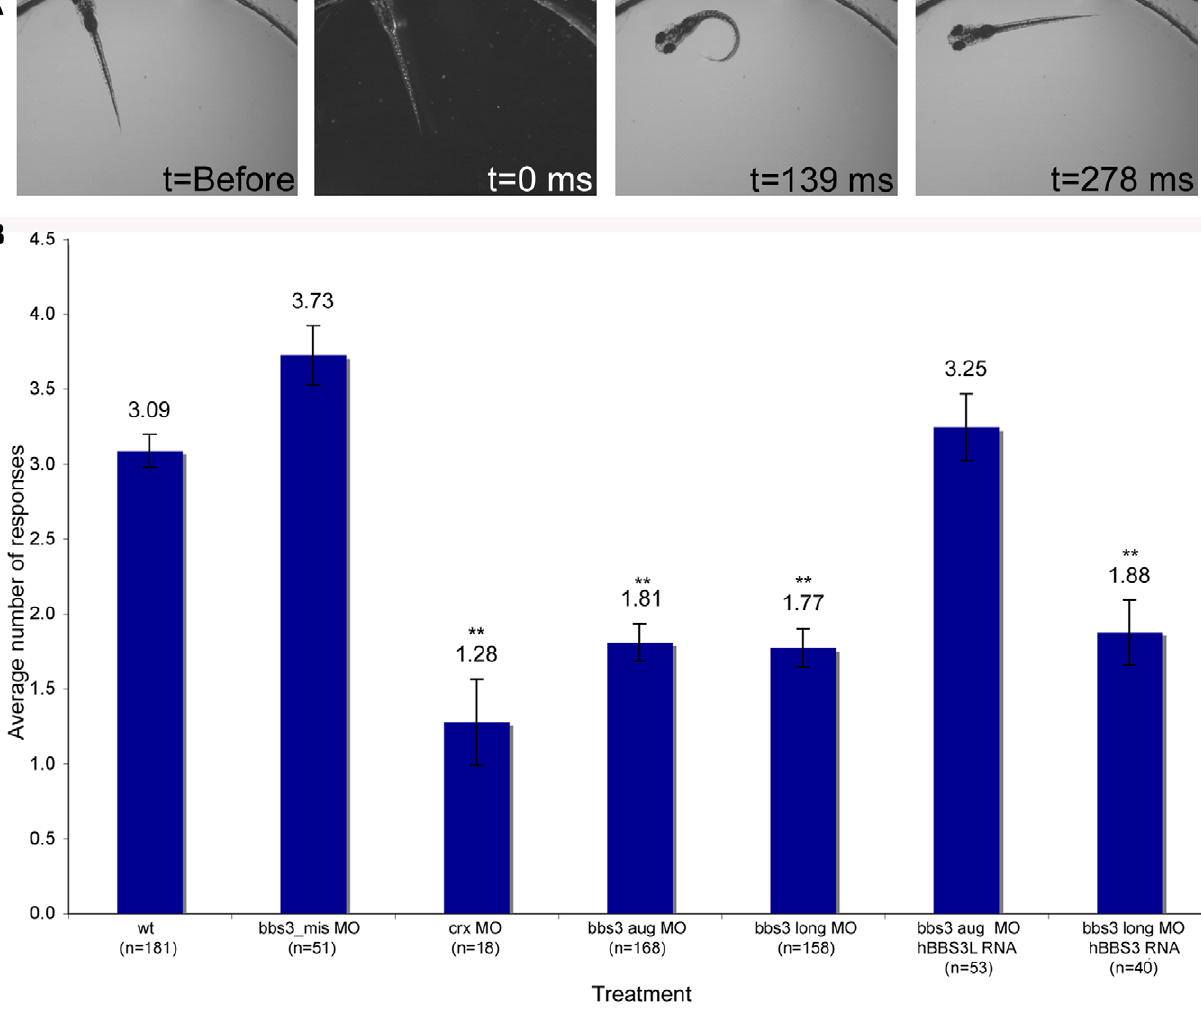
Figure 3. Vision startle response in zebrafish. (A) Vision function was assayed in 5-day old embryos by testing embryos sensitivity to short blocks in light at 30 second intervals for 5 trials (adapted from Easter and Nicola 1996). Selected images from a time-lapse collection before and immediately after a one second block in light. The typical response, a distinct C-bend, is scored as a positive response as shown in time point 139 ms. ms, milliseconds. (B) Quantification of the vision startle response for each treatment. Cone-rod homeobox ( crx ) gene knockdown was used as a control for vision impairment. bbs3 morphants lacking either both transcripts or only the long transcript showed a statistically significant reduction in the number of responses, indicating visual impairment. Rescue experiments using wild-type human BBS3L or BBS3 RNA co-injected with the bbs3 morpholinos demonstrated that h BBS3L RNA is sufficient to rescue the vision defect associated with knockdown, while h BBS3 is not sufficient to rescue the vision defect. The sample size (n) is noted on the x-axis. **ANOVA with Tukey, p ,